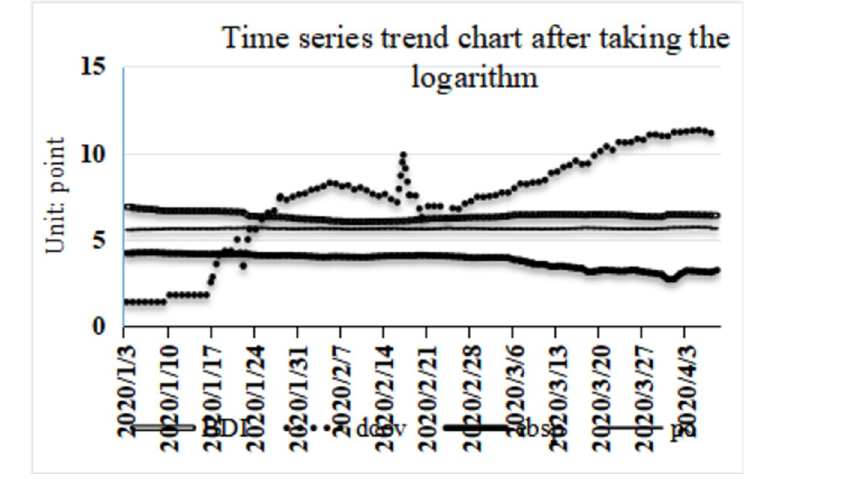
Fig 4. Logarithmic time series trend chart.